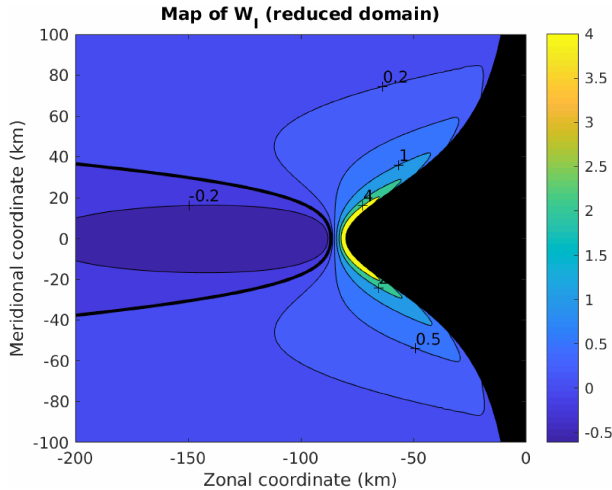
Figure 14. Dimensionless coefficient W I . It is independent of the period of the wave. Note that the domain is reduced in comparison with the previous